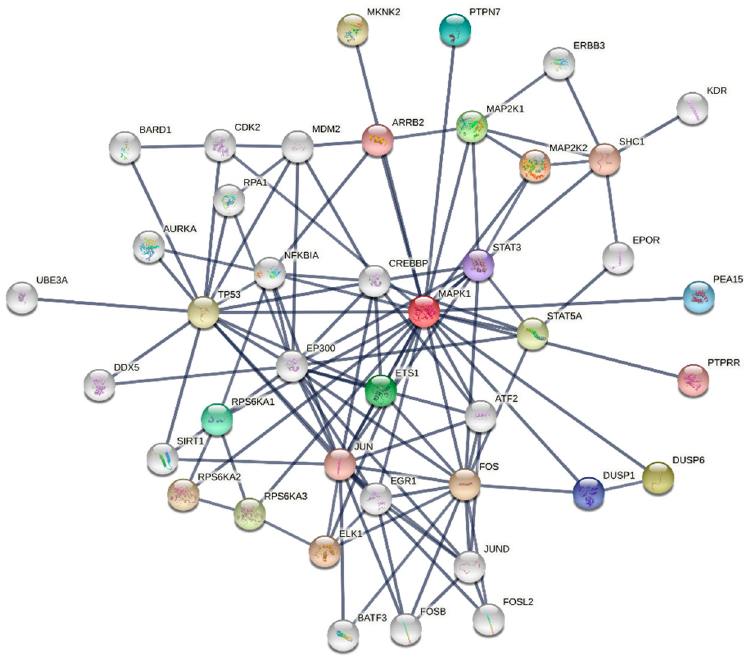
Figure 1. Interaction network of MAPK1. The network is built using the STRING database [100]. The top 20 first neighbors and top 20 second neighbors of MAPK1 (aka ERK1) are shown. The thickness of the edges is proportional to the confidence of the edges and the highest interaction score of 0.90 is selected to remove low-confidence connections.